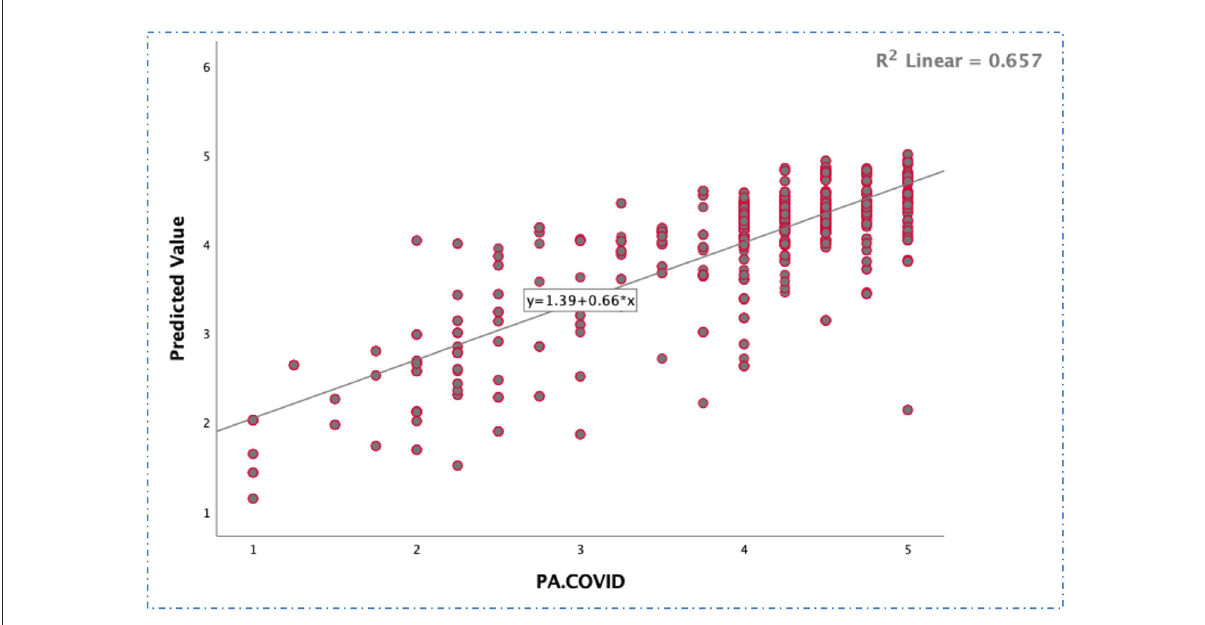
FIGURE7 Regression standard residuals for the COVID